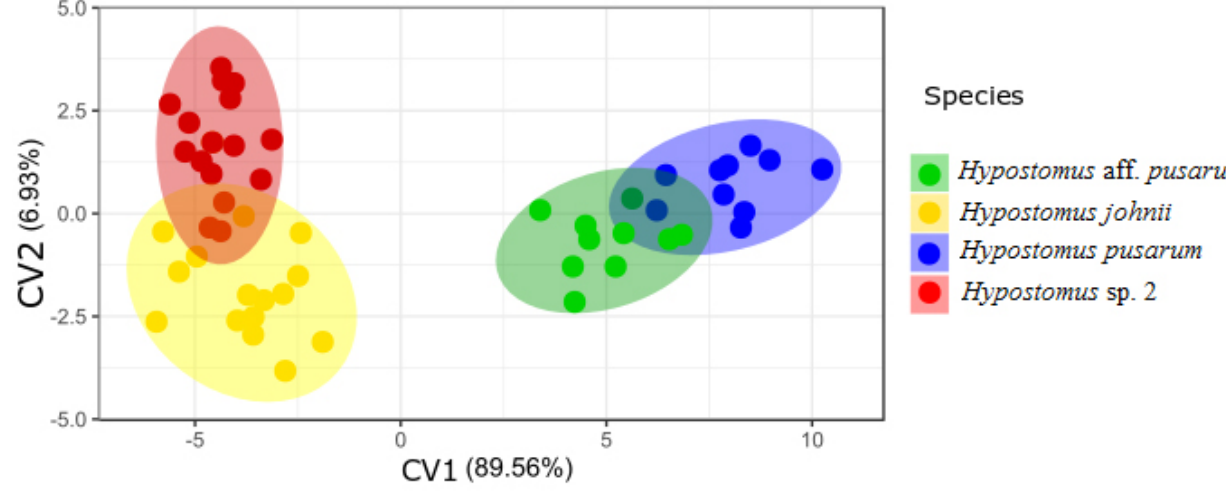
FIGURE 1 | Canonical Variable Analysis (CVA) with morphological data of Hypostomus species from the Parnaíba River